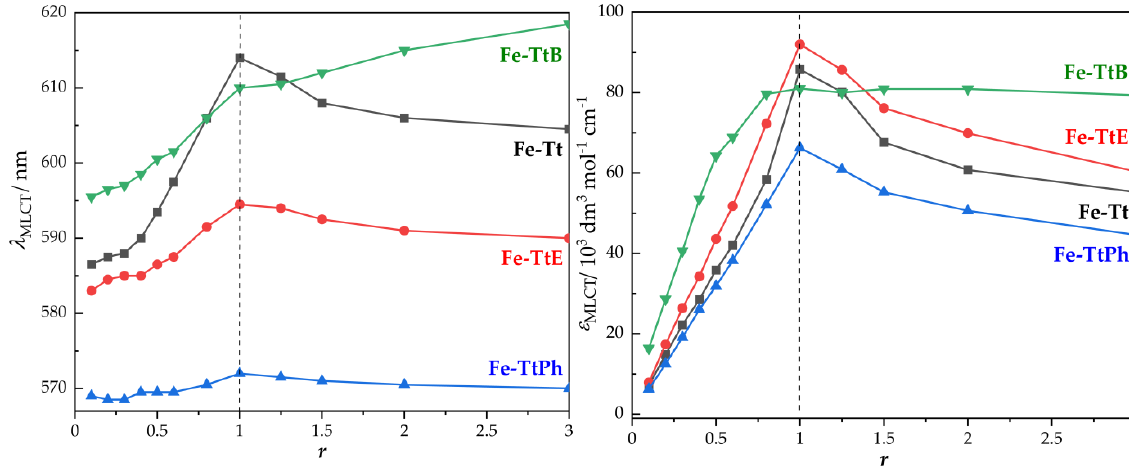
Figure 2. The wavelength ( λ MCLT , left) and the molar absorption coefficient ( ε MLCT , right) of the Metal to Ligand Charge Transfer (MLCT) band of unimer solutions with added Fe 2+ ions as a function of the ratio r = [Fe 2+ ]/[U]. Table 1. Positions of UV/vis absorption bands of Fe-MSPs ( r = 1.0) in the solid-state and in the teristic wavelengths of the absorption bands of unimeric units and MLCT, respectively.